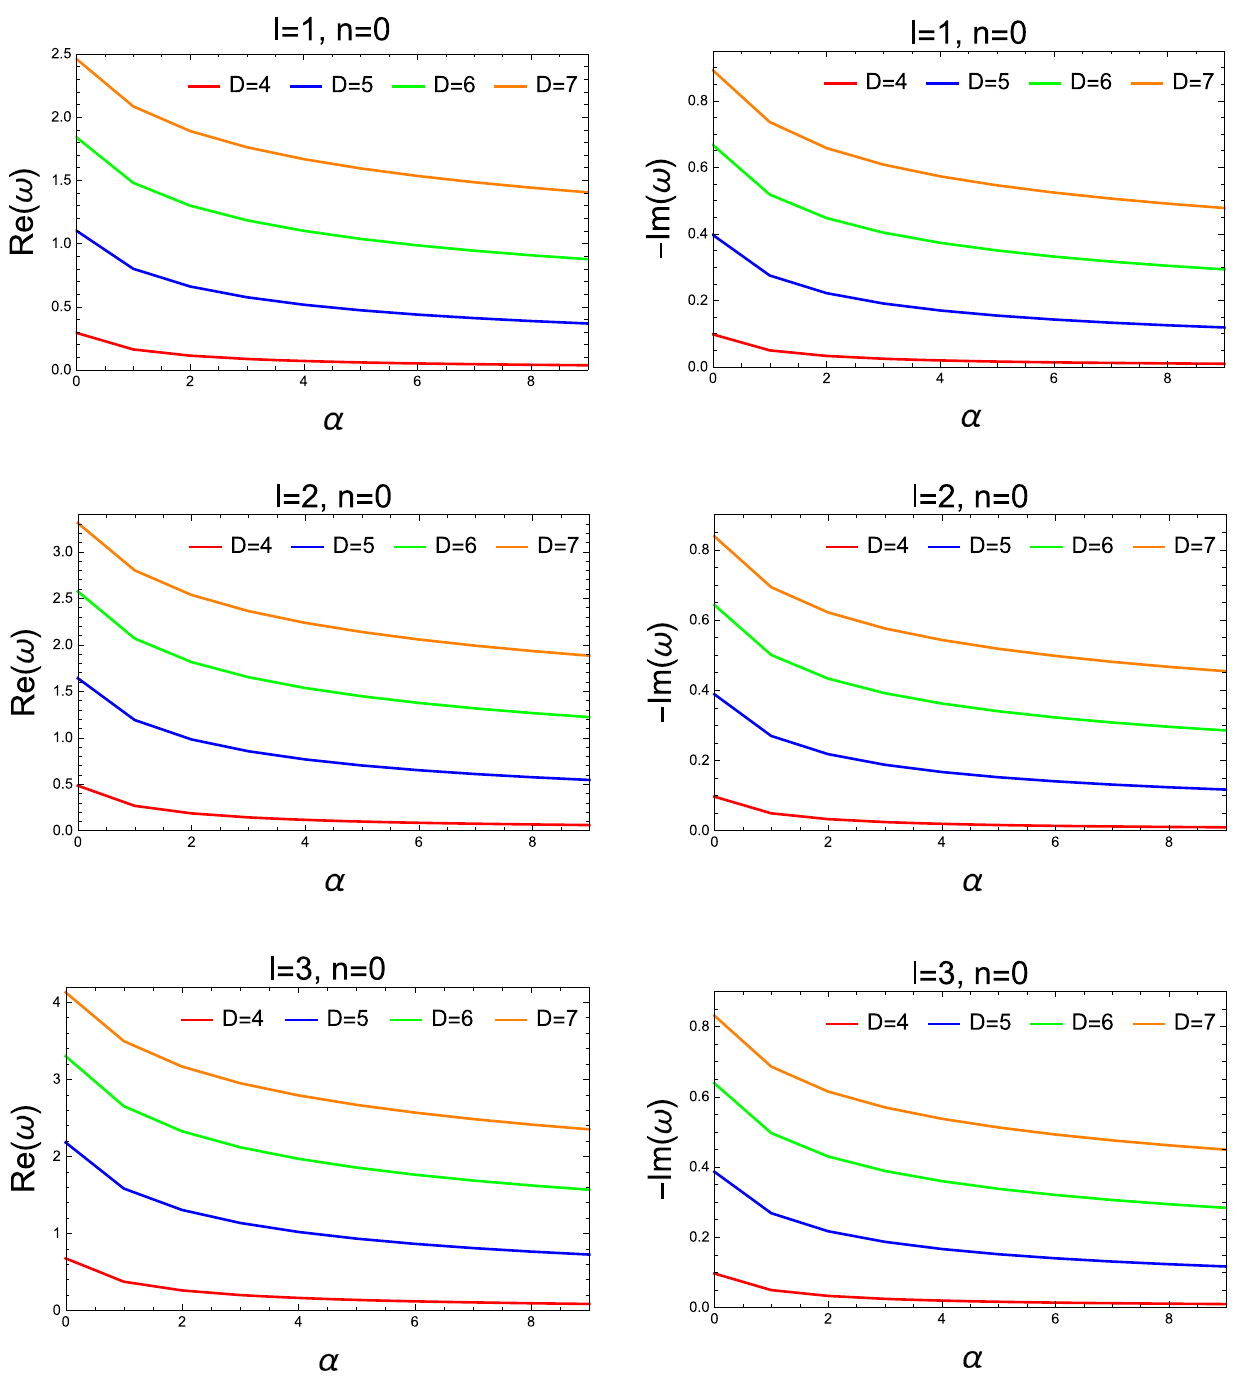
Fig. 3 Real parts and negative imaginary parts of quasinormal frequencies of massless scalar field perturbations with respect to α , where the spacetime dimension is taken to be D = 5 , 6 , 7, respectively, and the case of D = 4 is attached for comparison. Here we set M =